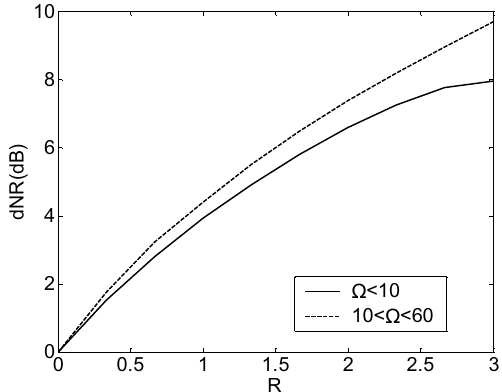
Fig. 10. Noise reduction versus the ratio of VEM layer to the base cylinder thicknesses (R) for an aluminum cylinder with the thickness of 3 mm and a/b = 0.994.